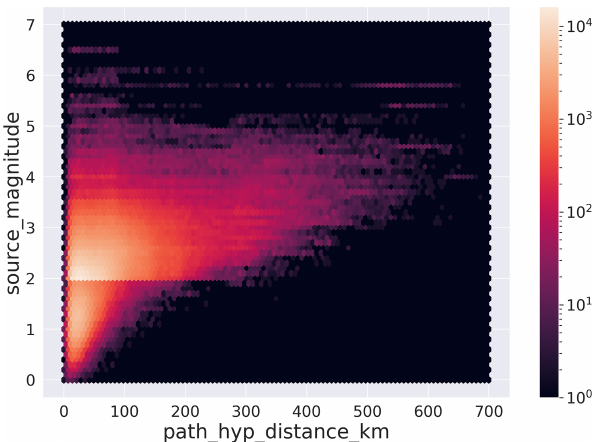
Figure 4. Diagram of the earthquake magnitude distribution of the dataset versus receiver distance represented as a hexbin plot. The labels are assigned using the metadata names listed in Table